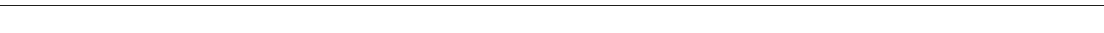
Fig. 8 Irisin rescues denervation-induced loss of muscle mass. a Graph showing average body weight (g) of mice injected with either DB (control) or irisin (2.5 μ g/g body weight) three times a week, 1 week prior to, and 2 weeks post transection of the sciatic nerve. Body weights were measured prior to injection. b Graph showing the percentage change in body weight (from initial) in mice injected with either DB (control) or irisin pre and post sciatic nerve transection ( n = 6 mice for both groups). c Graph displaying average TA, EDL, Gas, and Sol muscle weights of denervated mice injected with either DB (control) or irisin pre and post sciatic nerve transection. All hindlimb muscle weights were normalized to tibia length ( n = 5 mice for DB-injected group and 6 mice for irisin-injected group). d Representative images of H&E-stained TA muscle from non-denervated and denervated mice injected with either DB (control) or irisin. e Histogram and f line graph showing the distribution of TA myo fi ber CSA in non-denervated and denervated mice injected with either DB (control) or irisin. g Graph displaying the average total cross-sectional area of TA muscles from denervated mice injected with either DB (control) or irisin ( n = 3 mice for both groups). Error bars represent mean ± SEM. Student ’ s t -test was performed for all relevant fi gure panels. Signi fi cance is indicated with * p < 0.05 and ** p <